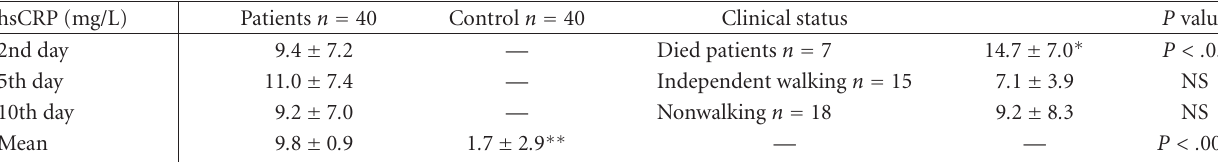
Table 2: Serum hsCRP levels of study and control groups (a) .